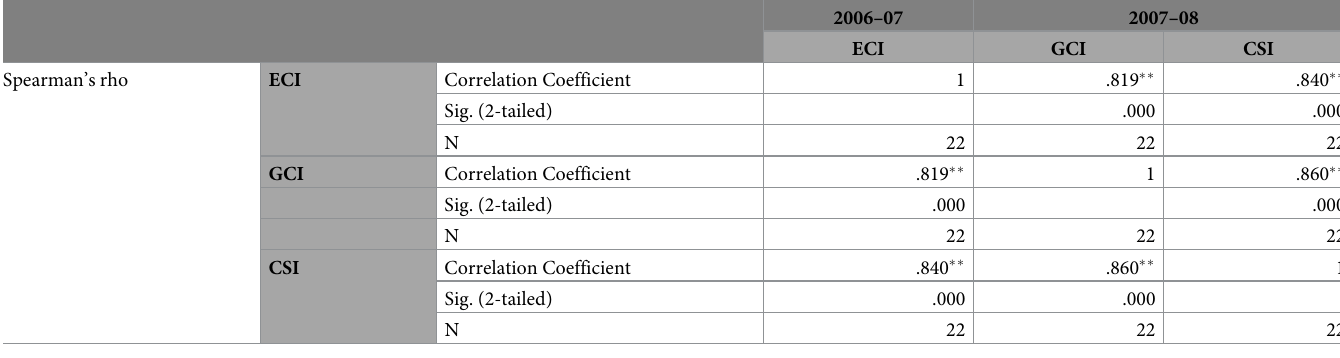
Table 10. Spearman’s correlations between ranks for the GCI and CSI in